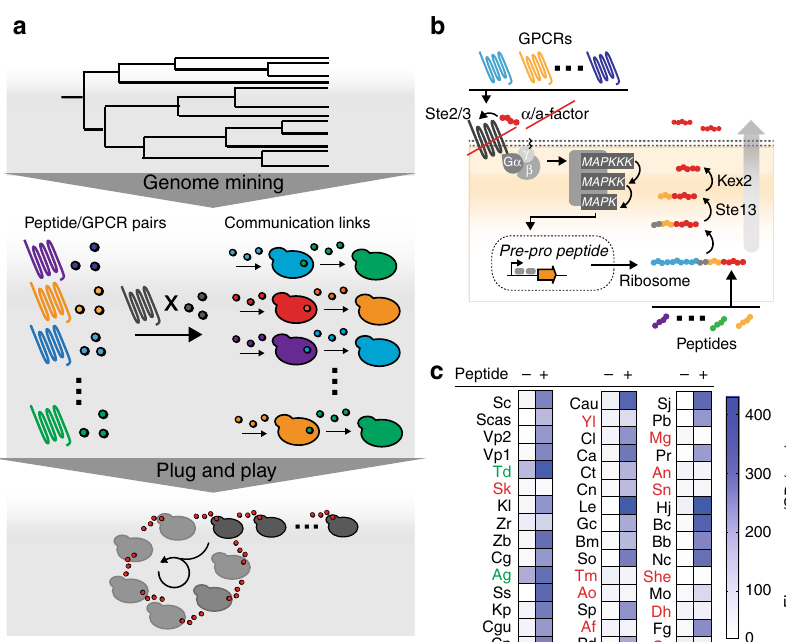
Fig. 1 Language component acquisition: genome-mining yields a scalable pool of peptide-GPCR interfaces. a Pipeline for component harvest and communication assembly. Upper panel: mining of Ascomycete genomes yields a scalable pool of peptide-GPCR pairs. Middle panel: GPCR activation can be coupled to peptide secretion to establish two-cell communication links. Each cell senses an incoming peptide signal via a speci fi c GPCR, with GPCR activation leading to secretion of an orthogonal user-chosen peptide. The secreted peptide serves as the outgoing signal sensed by the second cell. Lower panel: Scalable communication networks can be assembled in a plug-and play manner using the two-cell communication links. b GPCRs and peptides